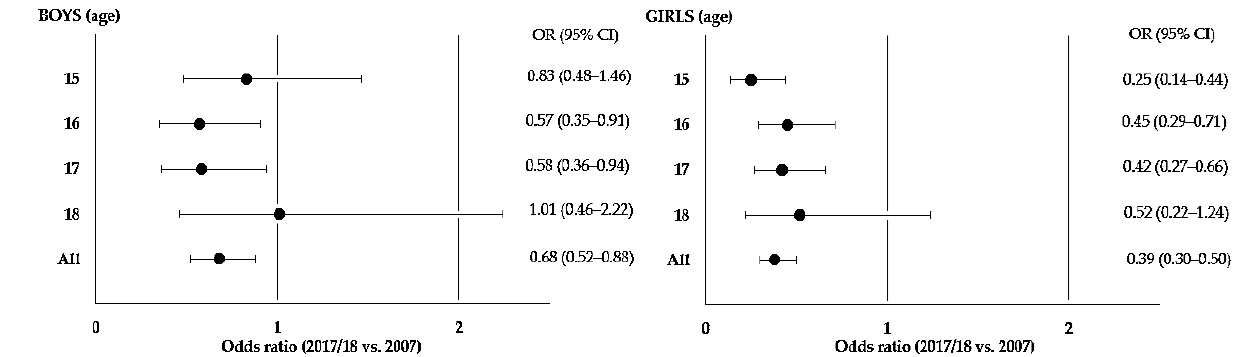
Figure 1. Age-specific odds ratios (ORs) with 95% confidence intervals (CIs) for sufficient PA in adolescents in 2017/18 compared with those in 2007. Florianopolis, SC, Brazil.